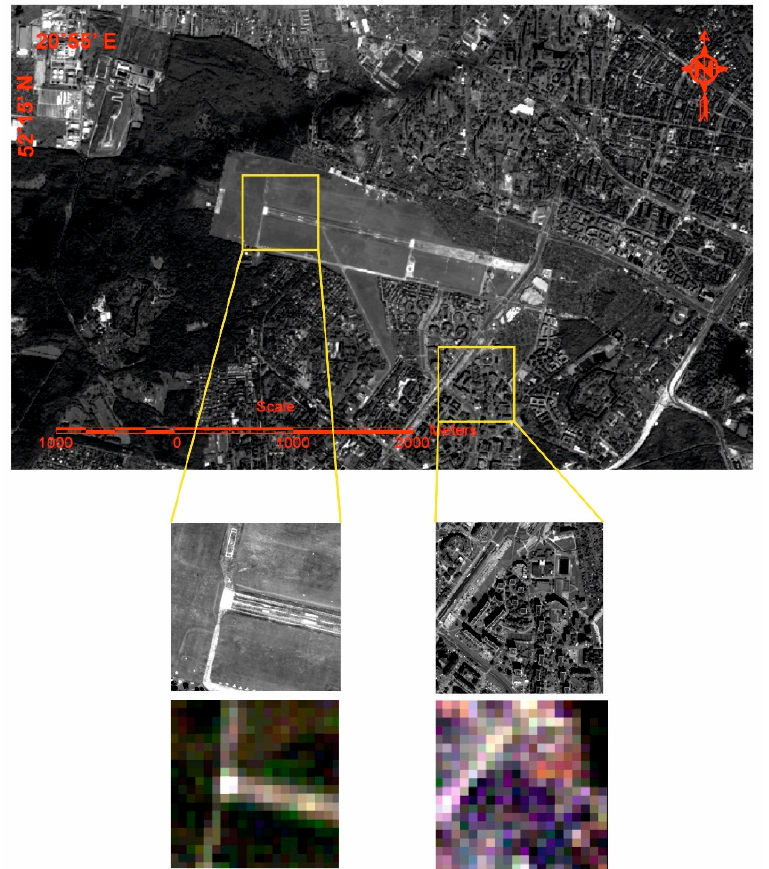
Figure 1. Study area—western Warsaw including regions of different types of land-use: panchromatic image form WorldView-2 (pixel size 0.5 m) and multispectral image from Landsat 5 TM (pixel size 30 m).